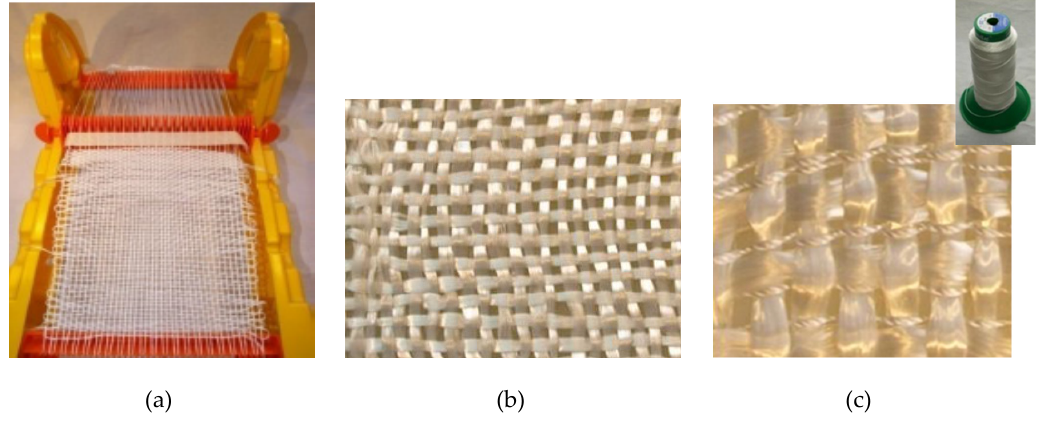
Figure 3. ( a ) Prototype loom. ( b ) Fiberglass fabric. ( c ) Fiberglass + PA hybrid fabric.